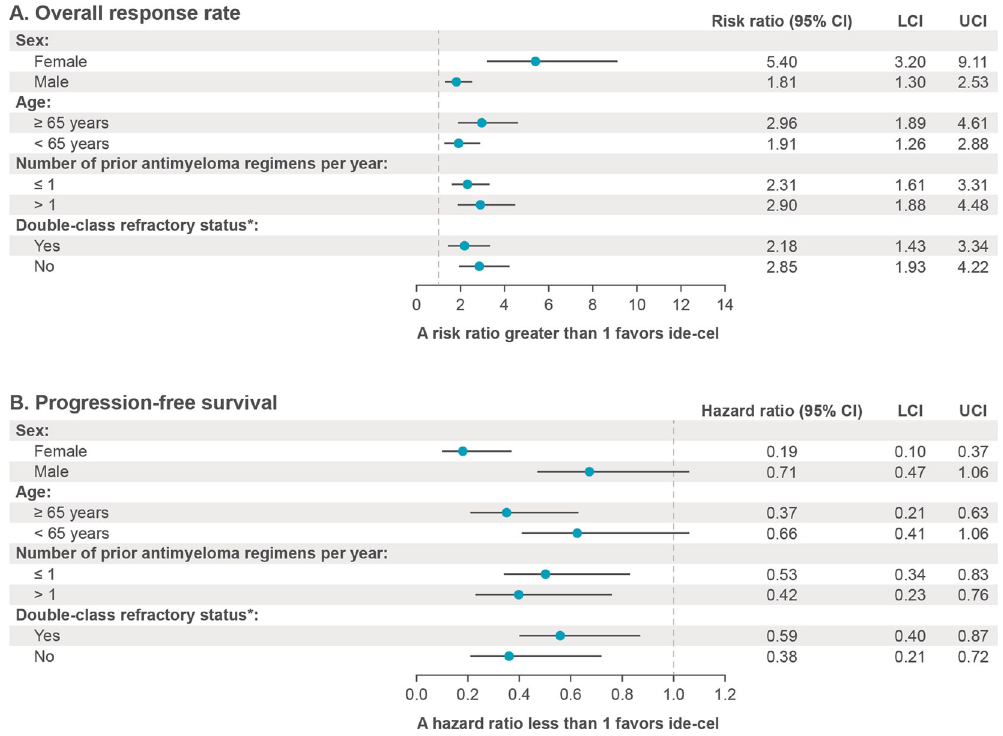
Fig. 4 Subgroup analyses of overall response rate and progression-free survival. A shows overall response rate (con fi rmed partial response or better) by patient demographics and disease characteristics. B shows progression-free survival by patient demographics and disease characteristics. Patients with a partial response or better according to International Myeloma Working Group criteria applying Food and Drug Administration censoring rules were included. Multiple imputations were performed to create 30 datasets; estimates for the analyses were then obtained using Rubin ’ s rule to combine the individual estimates from each dataset. *Double-class refractory was de fi ned as refractory to an immunomodulatory agent and a proteasome inhibitor. ORR denotes overall response rate, PFS progression-free